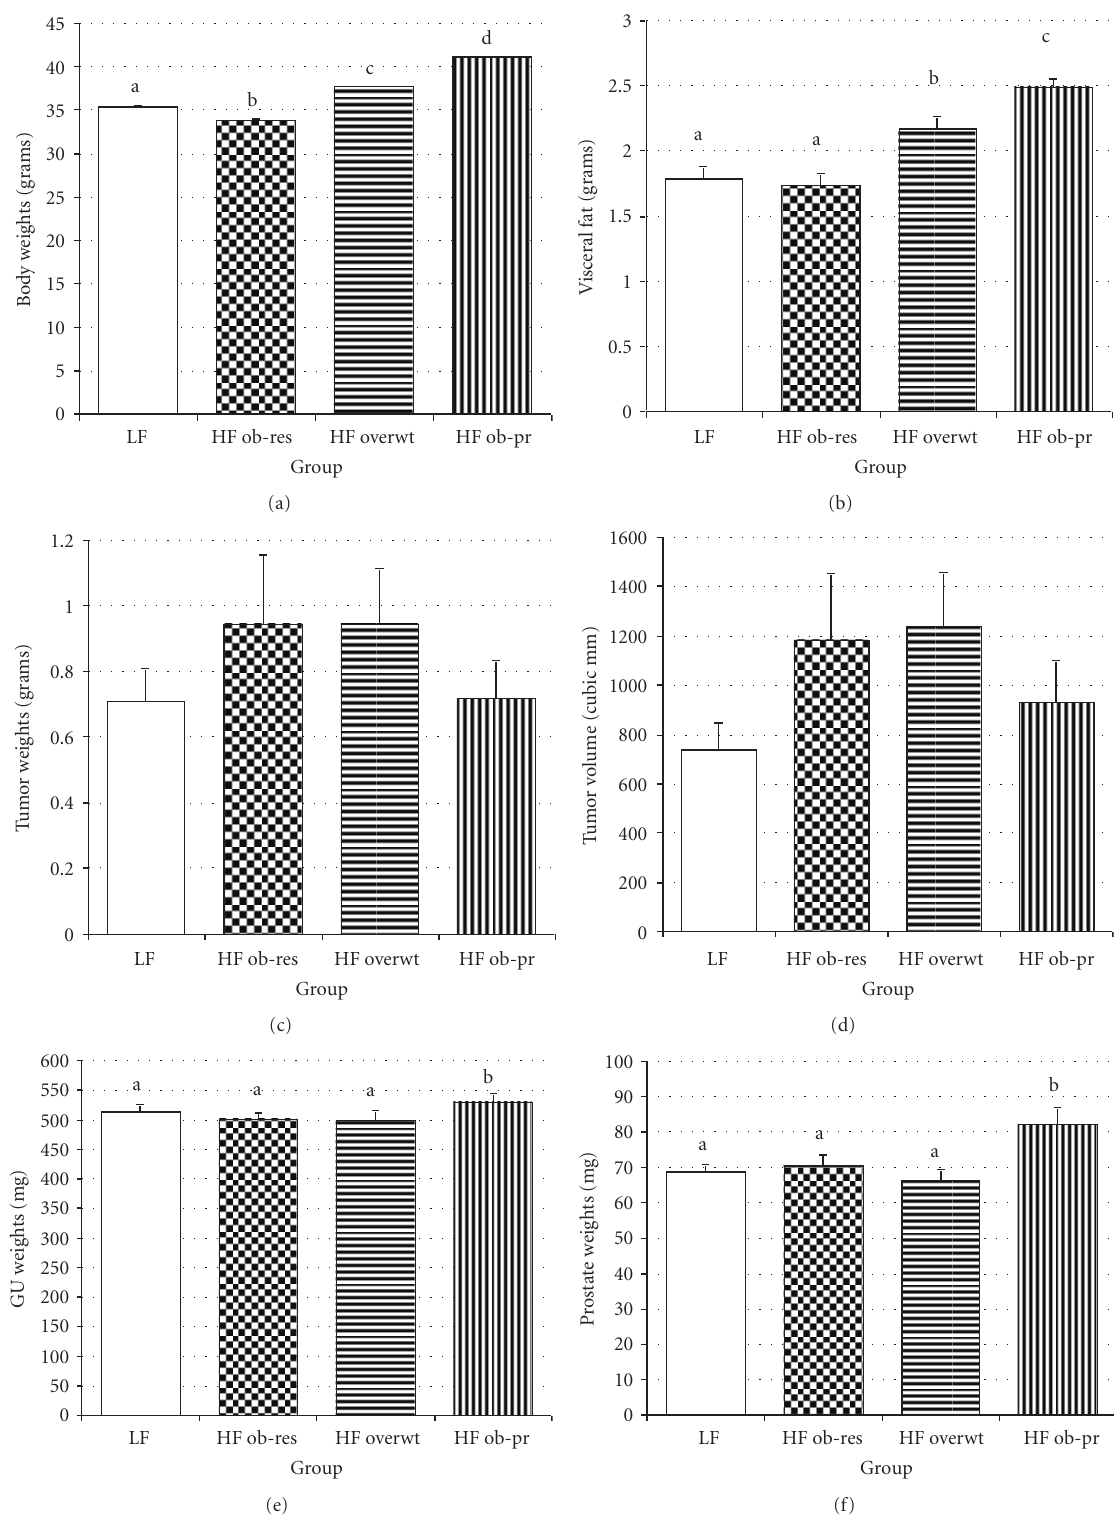
Figure 3: TRAMP-C2 tumor growth based on body weight and diet. Body weights of low-fat fed (open bars N = 40), high-fat fed obesity- resistant (checkered bars N = 38), high-fat fed overweight (horizontal bars N = 38), and high-fat fed obesity-prone (vertical bars N = 38) at 25 weeks of age. (a) Average body weights with grams along the y -axis (overall ANOVA P < 0 . 0001). (b) Average fat pad weights at termination in grams y -axis (overall ANOVA P < 0 . 0001). (c) Tumor weights at termination in grams ( y -axis and (d)). Tumor volume at termination in mm cubed ( y -axis). (e) Genitourinary tract (GU) weights with milligrams along the y -axis ( P < 0 . 01). (f) Prostate weights with milligrams along the y -axis ( P < 0 . 01). Bars represent standard error and letters show significance di ff